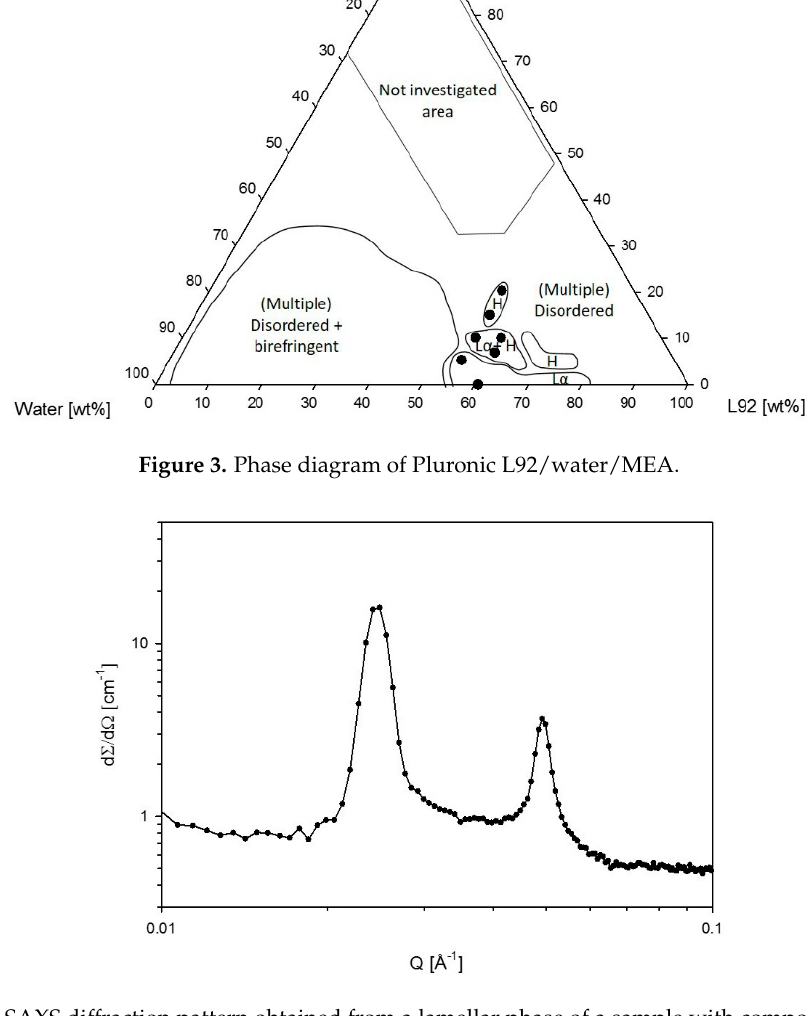
Figure 5. SAXS diffraction pattern obtained from a hexagonal phase of a sample with composition 75% L92/5% MEA. The peak positions follow the ratio 1: √ 3:2.